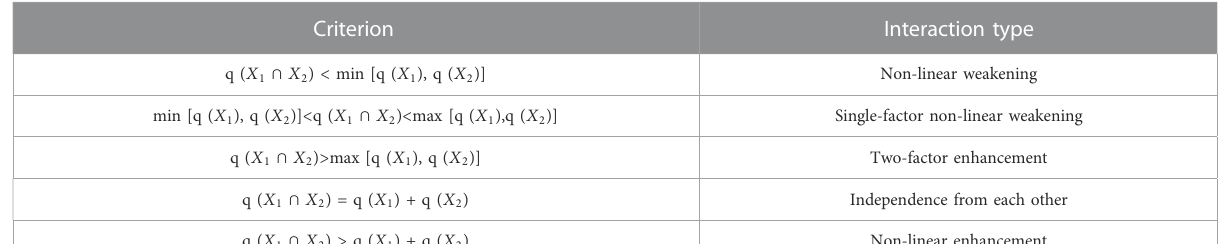
TABLE 2 Interaction detection